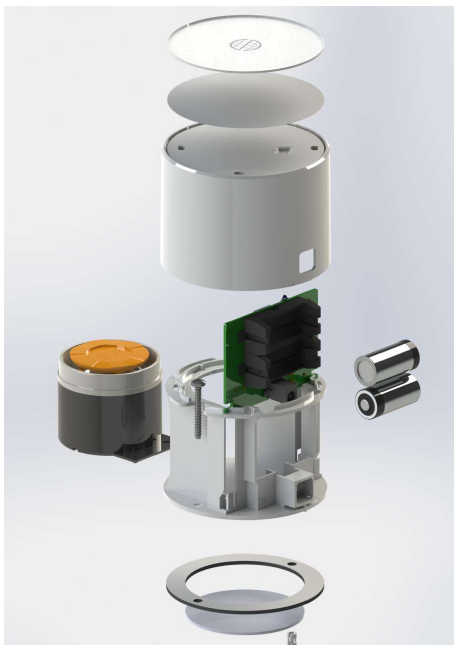
Figure 8. Detail of the packaging design of the siren node.